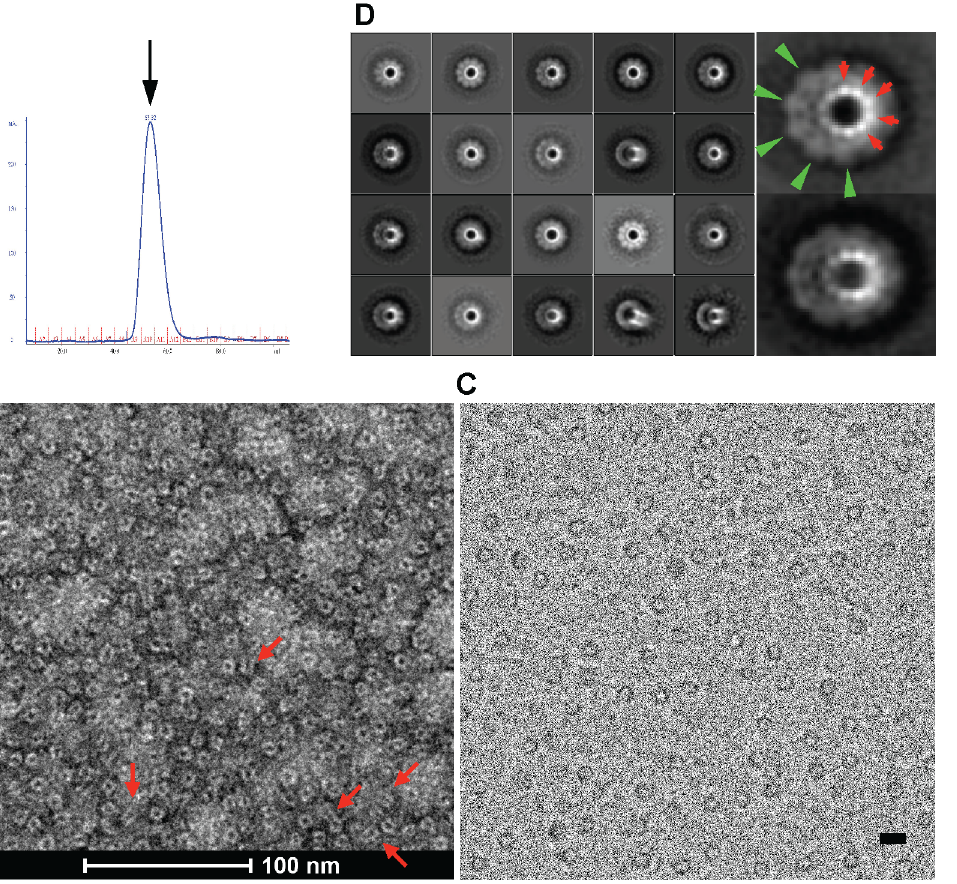
Fig 1. The gp12 assembles into a ring-like decamer. (A) Size exclusion chromatogram of the purified gp12 decamer. The peak corresponds to an estimated molecular weight of 471kDa, indicating a decamer (arrow). (B) Electron micrograph of the purified gp12 decamer negatively stained with uranyl acetate. Notice the dominant views are down the longitudinal axis of the gp12 decamer. Some side or tilted views are indicated with red arrows. (C) Electron micrograph of the frozen-hydrated gp12 decamer. Bar, 100 Å . (D) Class averages of the frozen-hydrated gp12 decamer. Enlarged views of two class averages are shown on the right. The 10-fold symmetry is clearly evident for both the crown (green arrowheads) and the stem domains (red arrows). The box size for class averages in the left panel is 309.8 Å .